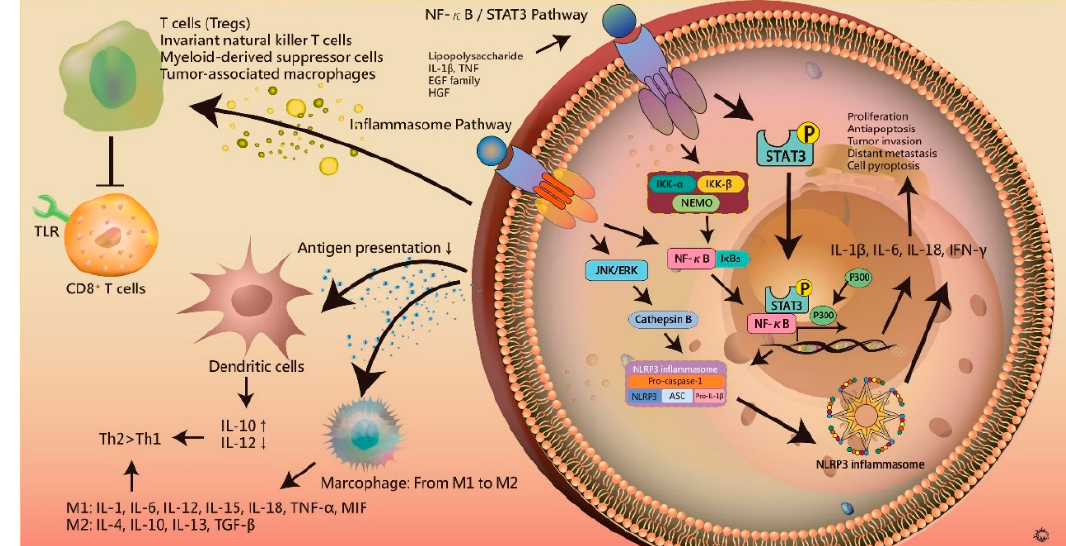
Figure 3. The role of immunity in hepatocarcinogenesis. After liver damage, cell dysfunction and death triggers local and systemic immune responses, leading to liver cirrhosis and hepatocarcinogenesis. Chronic liver inflammation causes the dysregulation of pro- and anti-inflammatory cytokines, such as IL-1 β , IL-6, IL-10, IL-12, IL-13, IL-18, and TGF- β , which inhibit anti-tumor immune responses. The activation of NF- κ B and STAT3 signaling is also involved. NF- κ B also correlates with the formation of inflammasome, leading to the release of IL-1 β . The dysregulated cytokines inhibit antigen presentation cells, leading to over-expression of Th2 cytokines, and decrease the activity of CD8+ T cells via T regulatory cells, invariant natural killer T cells, myeloid-derived suppressor cells, and tumor-associated macrophages, causing immune escape.